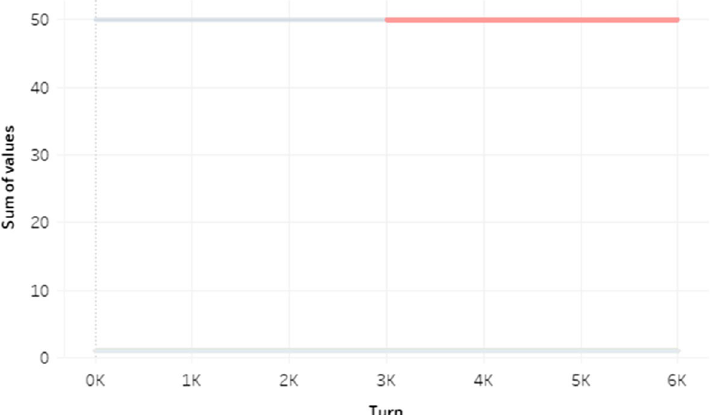
Fig. 6 Introduction of the cryptocurrency payments, case 1-A: Time series change of the sum of possession. The red line is the cryptocurrency good and other colors are remaining goods. After turn 3001 of the cryptocurrency good introduction, the total number remains constant at 50 throughout all